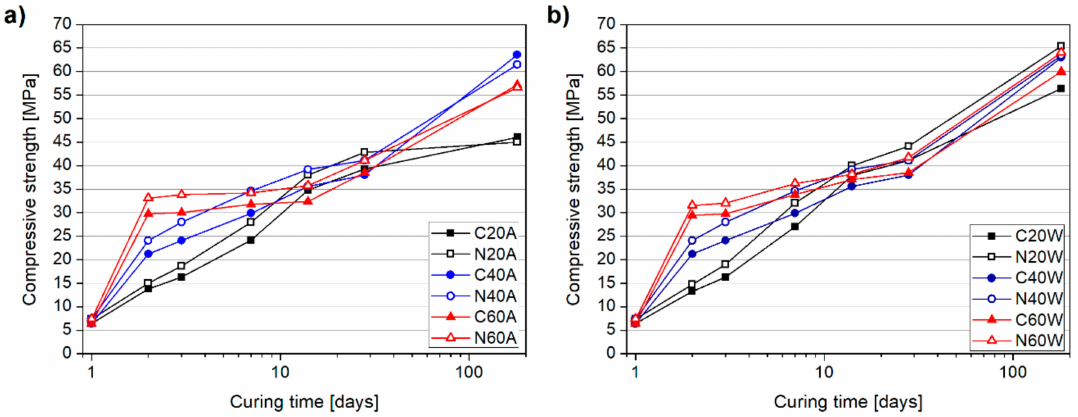
Figure 6. Specimens’ compressive strength development for up to 180 days of hot air curing ( a ) and hot water curing ( b